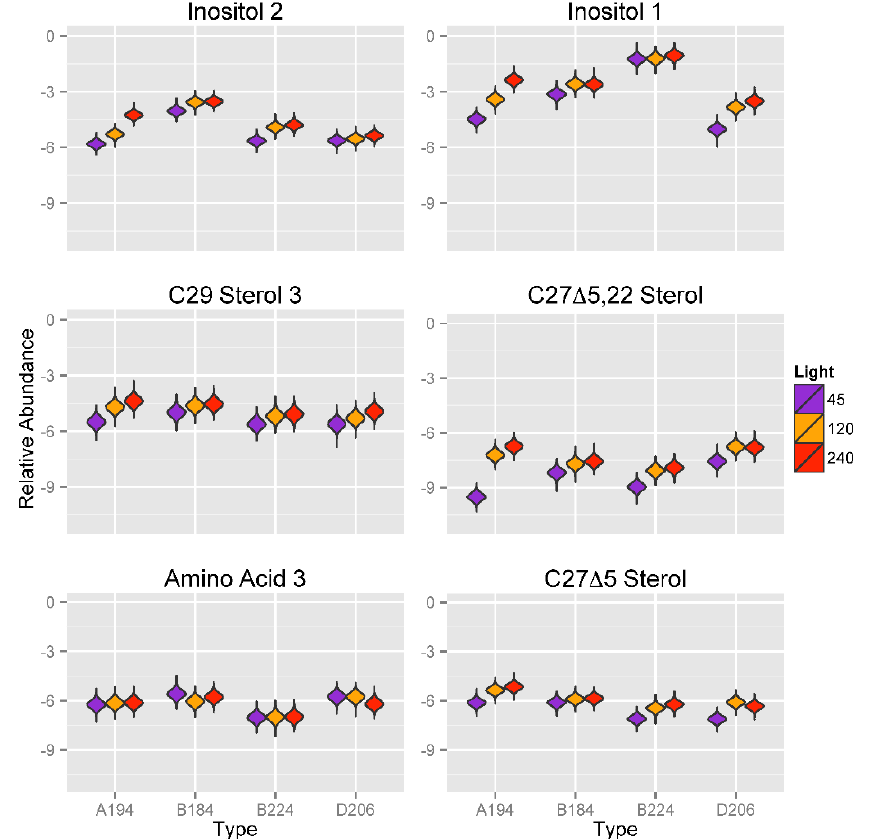
Figure 7. Violin plots showing posterior distributions of estimates of the top six significant predictor metabolites of light intensity (μmol photons m −2 s −1 ) for each Symbiodinium type. Metabolite abundance values are Area Under the Curve (AUC)-normalized. Predictor metabolites are sorted from top left to lower right according to their relative importance scores derived from Random Forests analysis. The width of each figure in the violin plot is proportional to the relative frequency of values from the posterior